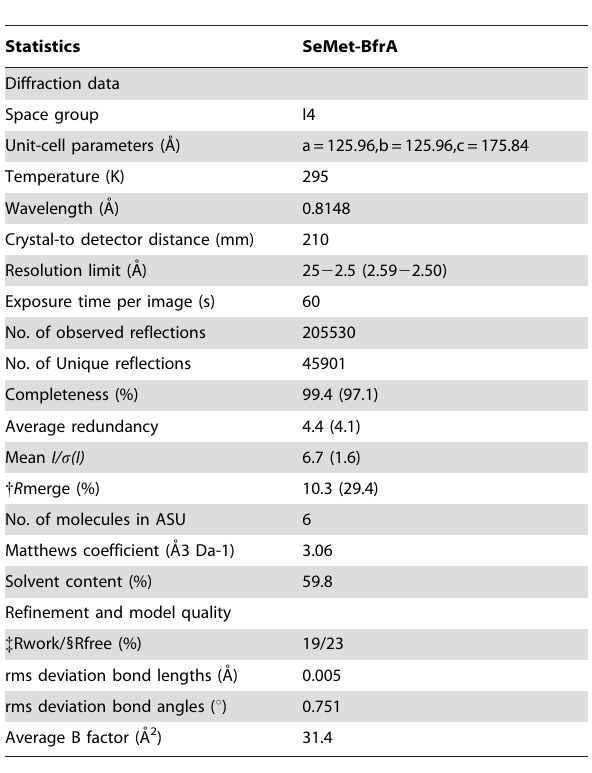
Table 2. Data collection and refinement statistics for Mtb SeMet-BfrA